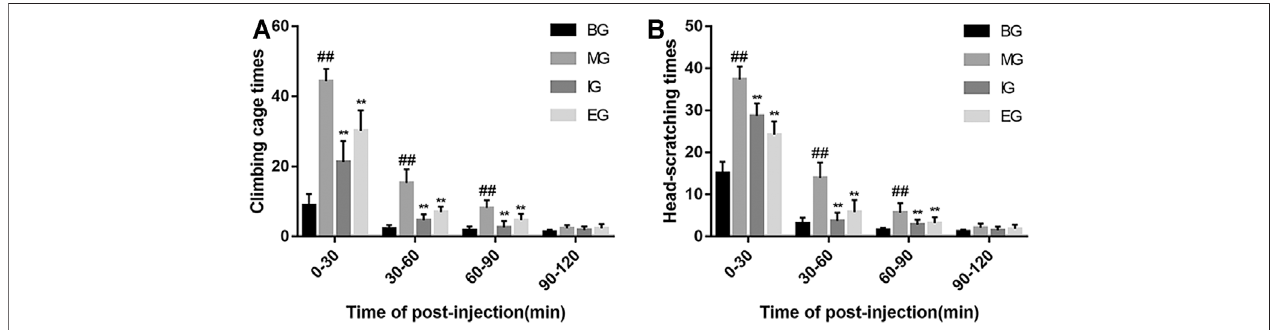
FIGURE2| PainresponseofratsindifferentgroupsafterNTGtreatment. (A) Thenumberofcagesclimbingineachratgroup. (B) Thenumberofheadscratchingin each rat group. Within 2 h after the injection of nitroglycerin, the number of cages climbing and head scratching were respectively recorded every 30 min. Data were expressed as mean ± SD ( n (cid:1) 12); ## p < 0.01 vs. the BG; ** p < 0.01 vs. the MG. Emodin reduced NO levels after NTG treatment.